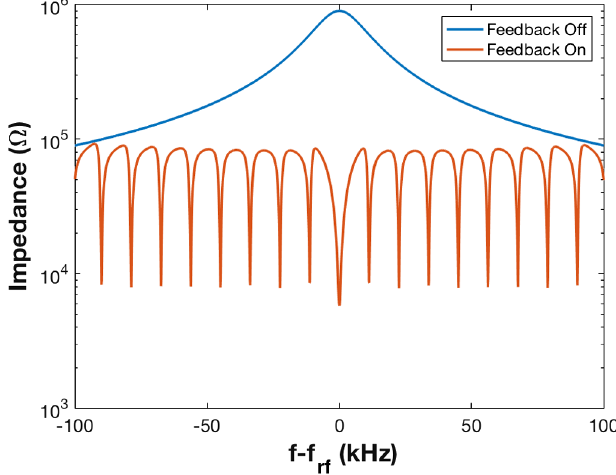
FIG. 4. Modulus of cavity impedance with OTFB. Injection settings: Q L ¼ 20000 , V c ¼ 1 MV, cavity on tune. impedance is reduced from 0 . 9 M Ω (no feedback) to about 8 k Ω on the revolution frequency sidebands ¼ 11245 Hz). ( f rev Figure 5 shows the same result in physics ( Q L ¼ 60000 [16]). The initial cavity impedance is three times higher ( 2 . 7 M Ω as it scales with Q L ), but the reduced impedance is the same. The llrf adjusts the gain tracking the main coupler position ( Q L ) so that the reduced impedance ( ≈ 70 k Ω = cavity with OTFB off, about 9 k Ω = cavity with OTFB on) is only defined by the physical limitation due to the loop delay. The above figures are computed from an analytical expression for cavity and llrf processing. Data from the physical implementation will be shown below.